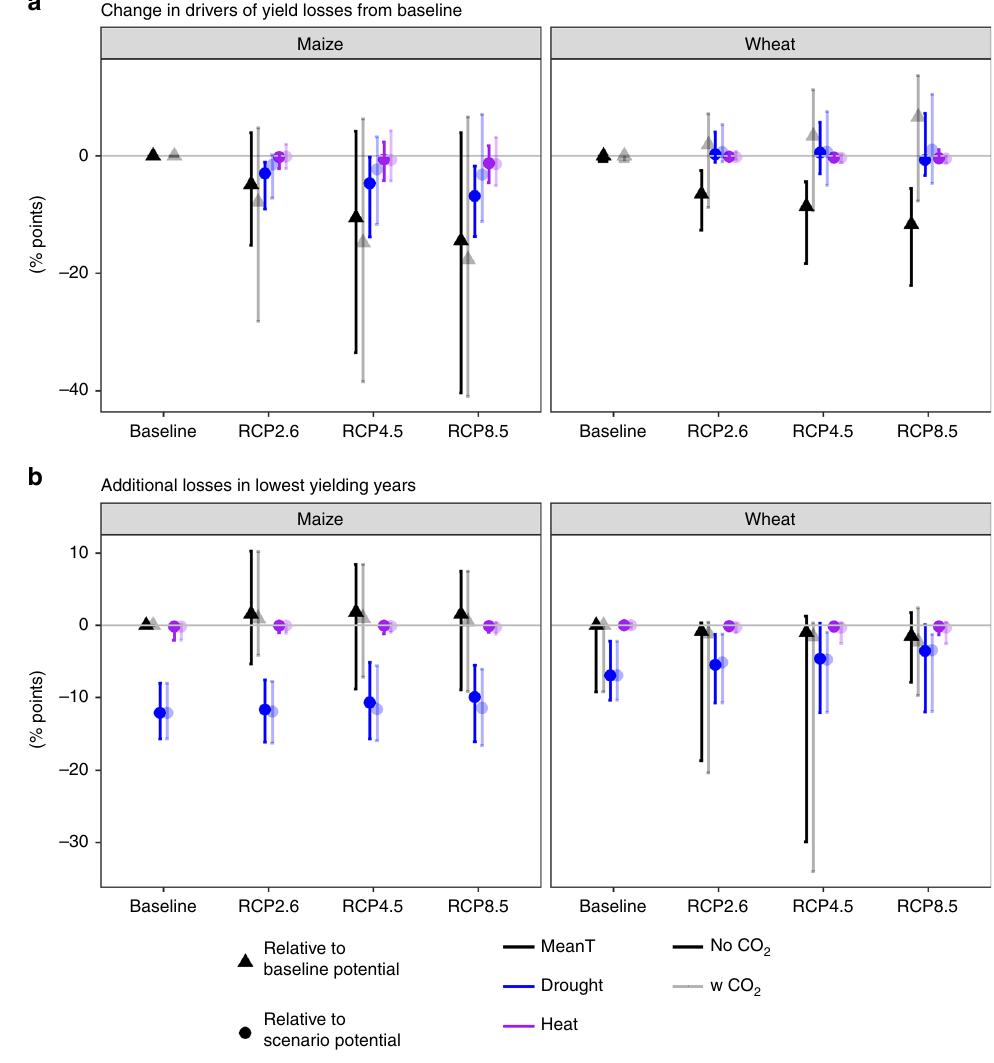
Fig. 4 Changes in drivers of yield losses in average and low-yielding years for European rainfed systems. Baseline refers to the period 1981 to 2010 and the scenario period is 2040 to 2069. a Two measures of change in average yields are presented. The black triangles indicate changes in potential yields due to mean temperature effects relative to potential yields in the baseline period (1981 – 2010). The second type of change shown is the absolute difference between the scenario and baseline (circles) of drought (blue) or heat (purple) losses relative to potential levels in the respective scenario (circles) for three representative concentration pathways (RCPs). b Difference (% points) between average yield levels and yields in lowest decile of losses for losses from potential yield levels due to mean temperature effects (black), drought limitation (blue), or heat limitation (purple) for the baseline period (1981 – 2010) and three RCPs (2040 – 2069). For all panels, maize is shown on the left and winter wheat on the right. Results are shown with (darker shading) and without (lighter shading) CO 2 fertilization effects. Data shown are the EU aggregates with median values across crop model and GCM combinations with error